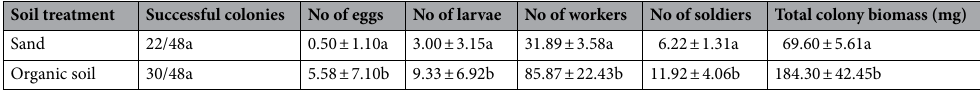
Table 1. Incipient termite colony growth (0–14 months). For each colony growth variable (mean ± SD), the same letter indicates no significant difference ( χ 2 , or t test, α = 0.05).